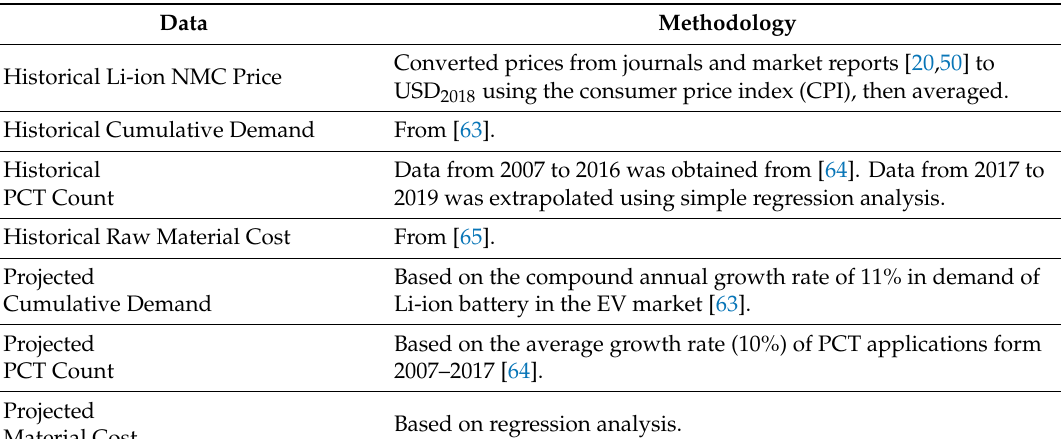
Table A2. Sources of the historical and forecasted